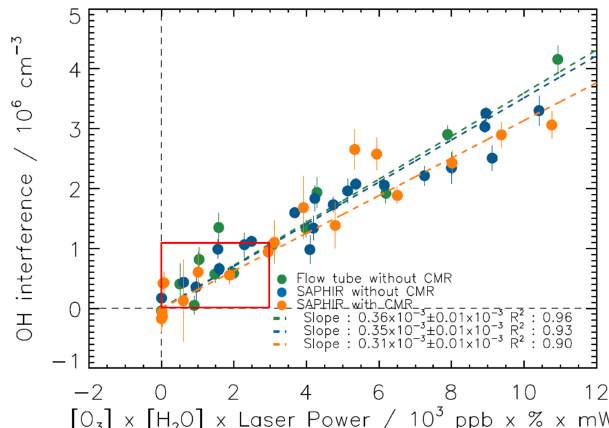
Figure 5. OH interference, expressed as equivalent ambient OH concentration, from the laser photolysis of ozone in humidified syn- thetic air for a range of concentrations of ozone, water vapour and laser power. Tests were done with and without the CMR with a flow tube or in chamber experiments. Measurements were fitted to a lin- ear function forced through the origin. The red box specifies the interference for concentrations of ozone and water vapour normally observed in the lower